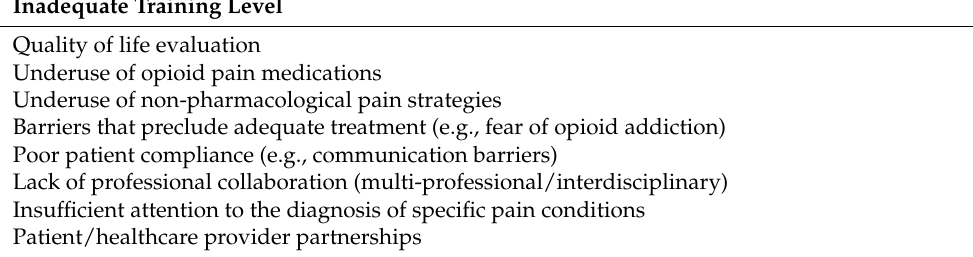
Table 1. Issues of